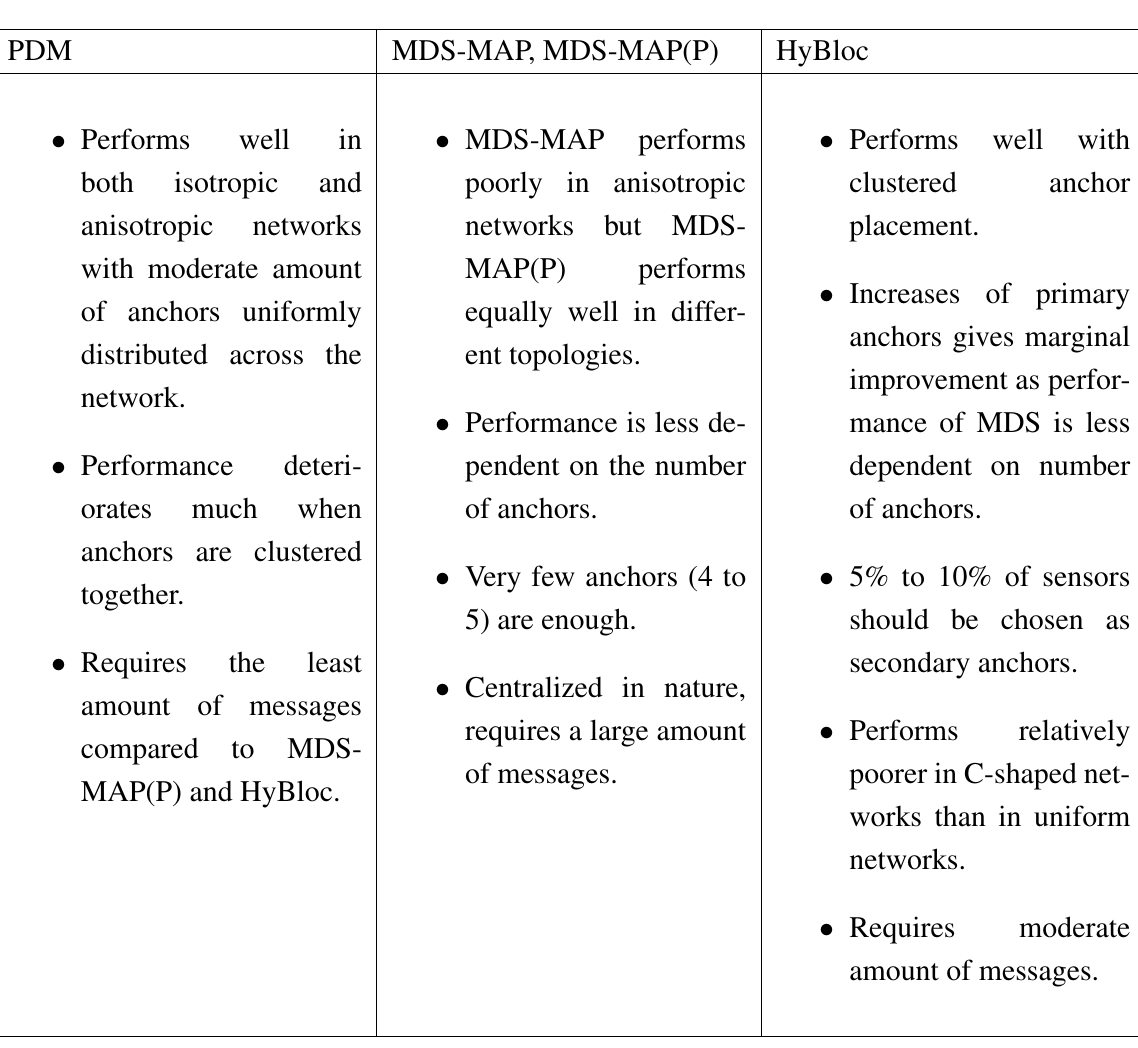
Table 1 . Summary of Simulation